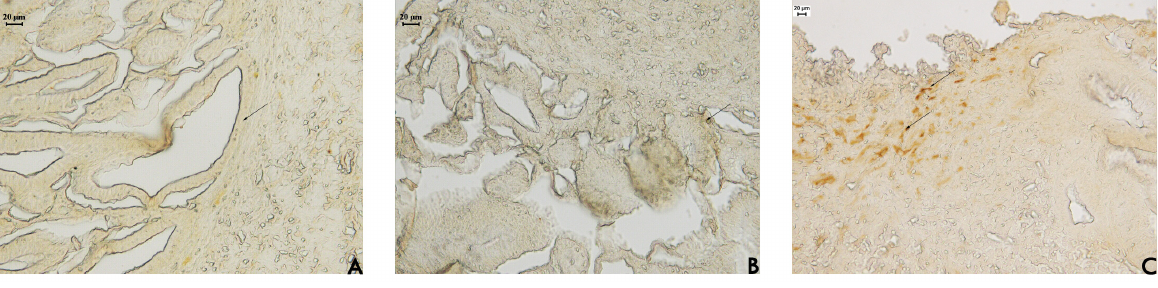
Figure 5. Photomicrographs submucosa from the stomach of rats subjected to different treatments. ( A ) vehicle (10 mL/kg); ( B ) cimetidine (100 mg/kg); and ( C ) ethyl acetate fraction of Alchornea triplinervia (100 mg/kg) immunostained of stomach of rat with COX-2 (scale represents 20 µm). The arrows denote cells COX-2 positive and note the high intensity of COX-2 label at lesion area in